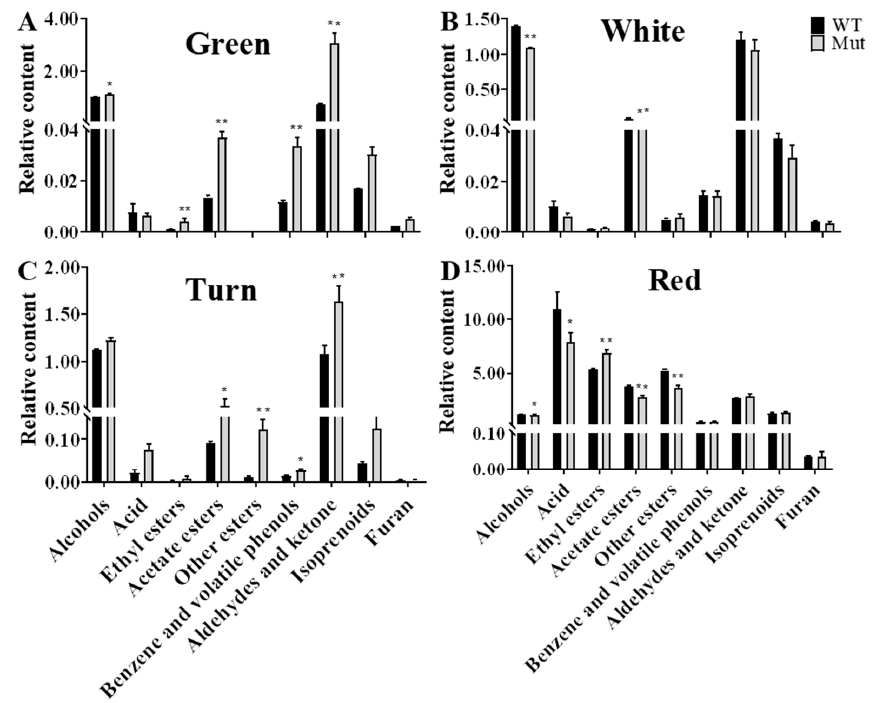
Figure 2. Comparative analysis of the contents of nine categories of volatile components in ‘Sachinoka’ strawberry and its somaclonal mutant ‘Mixue’ at different developmental stages. WT represents cultivated strawberry ‘Sachinoka’. Mut represents somaclonal mutant ‘Mixue’. * ( p < 0.05) and ** ( p < 0.01) represent significant differences in volatile components contents between the nine major categories of ‘Sachinoka’ strawberry and its somaclonal mutant ‘Mixue’.